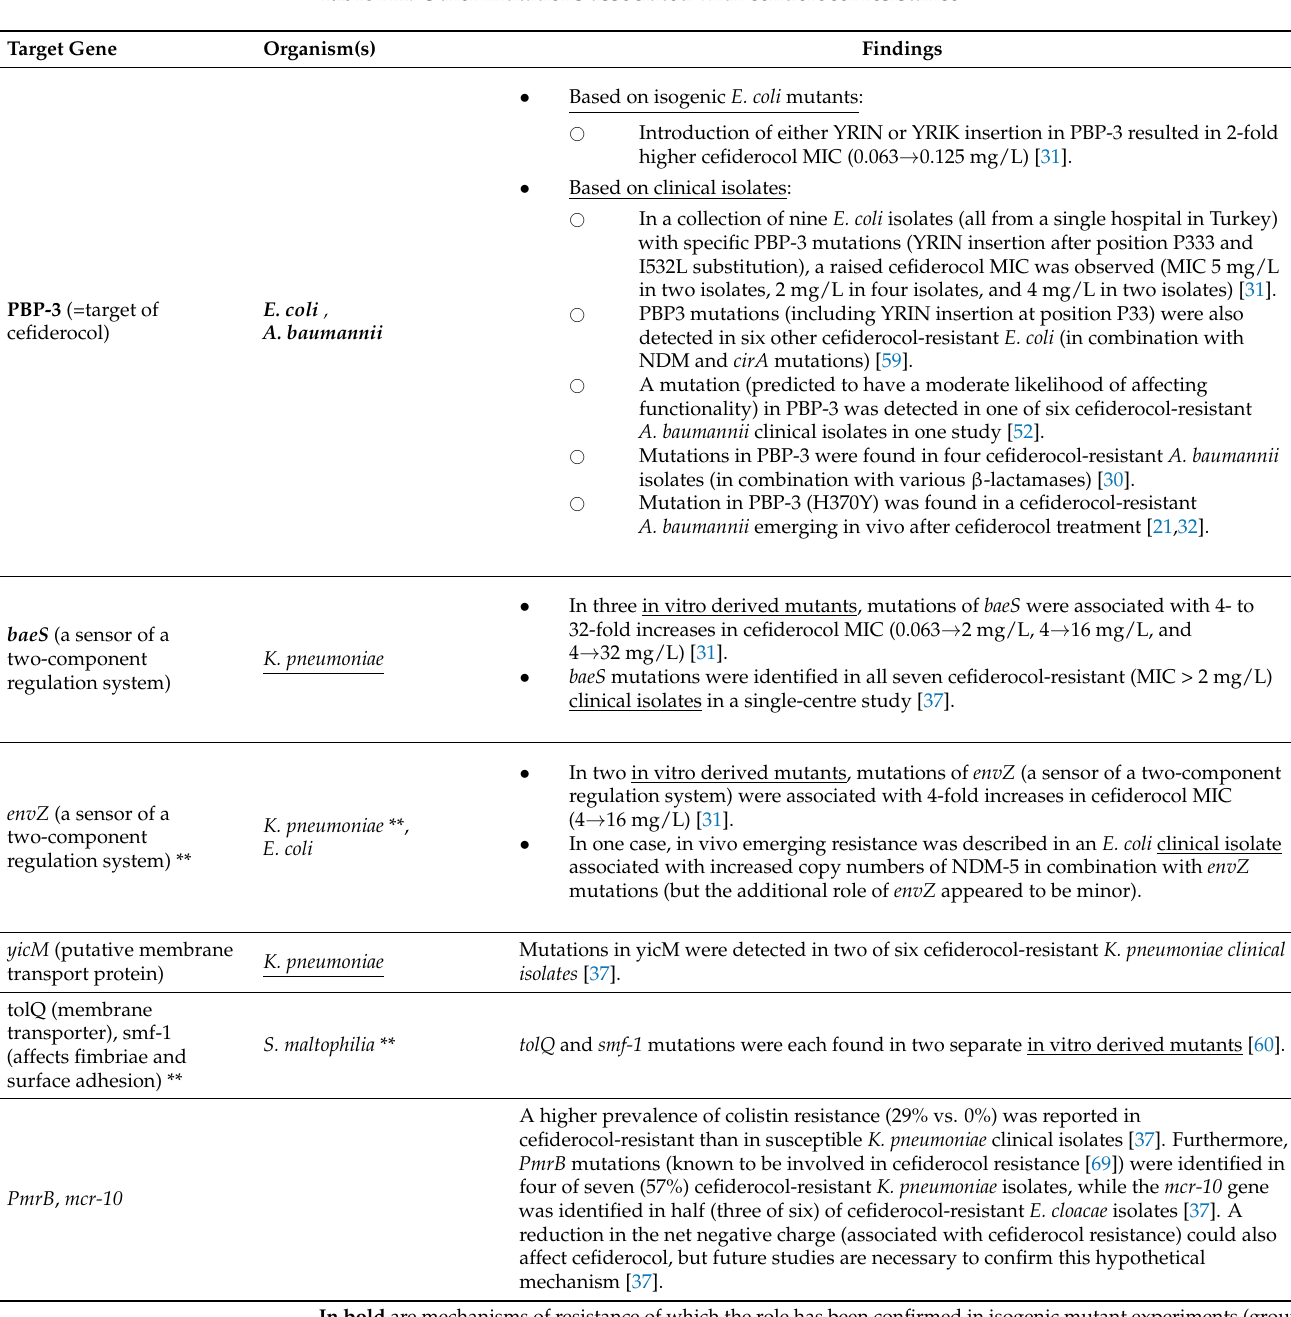
Table A4. Other mutations associated with cefiderocol